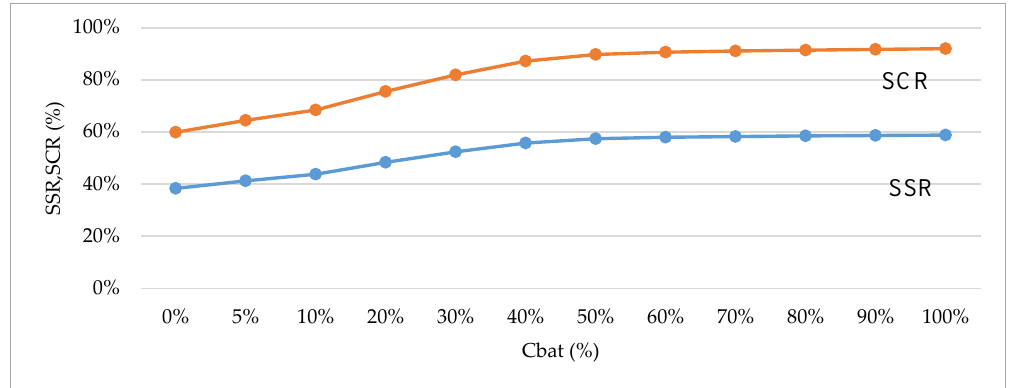
Figure 10. Comparison of the various storage capacity and the SSR and self-consumption rate ( SCR ) values ( MC1 ).